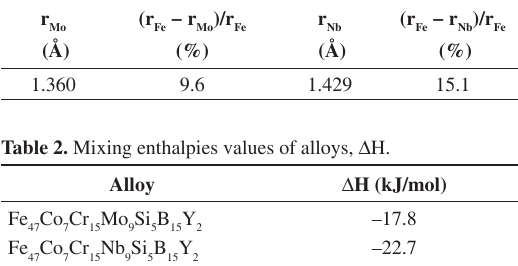
, r , r and the atomic Mo Nb Fe)